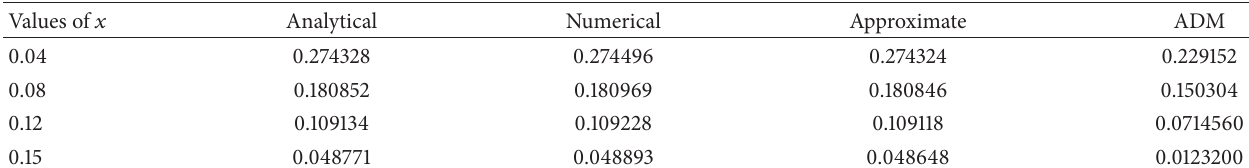
Table 2: A comparison for the surface concentration 𝑢(𝑡,0) with 𝑢 1 (𝑡,0) [1].